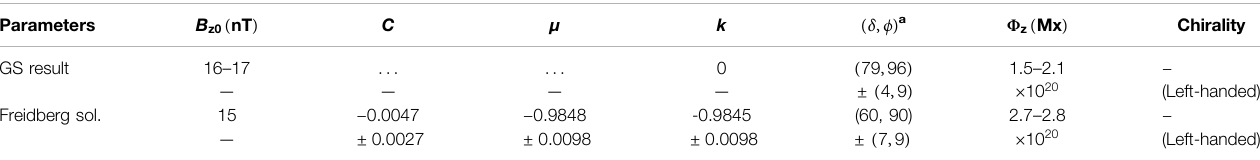
TABLE 1 | Summary of geometrical and physical parameters for the MC based on Wind spacecraft measurements.